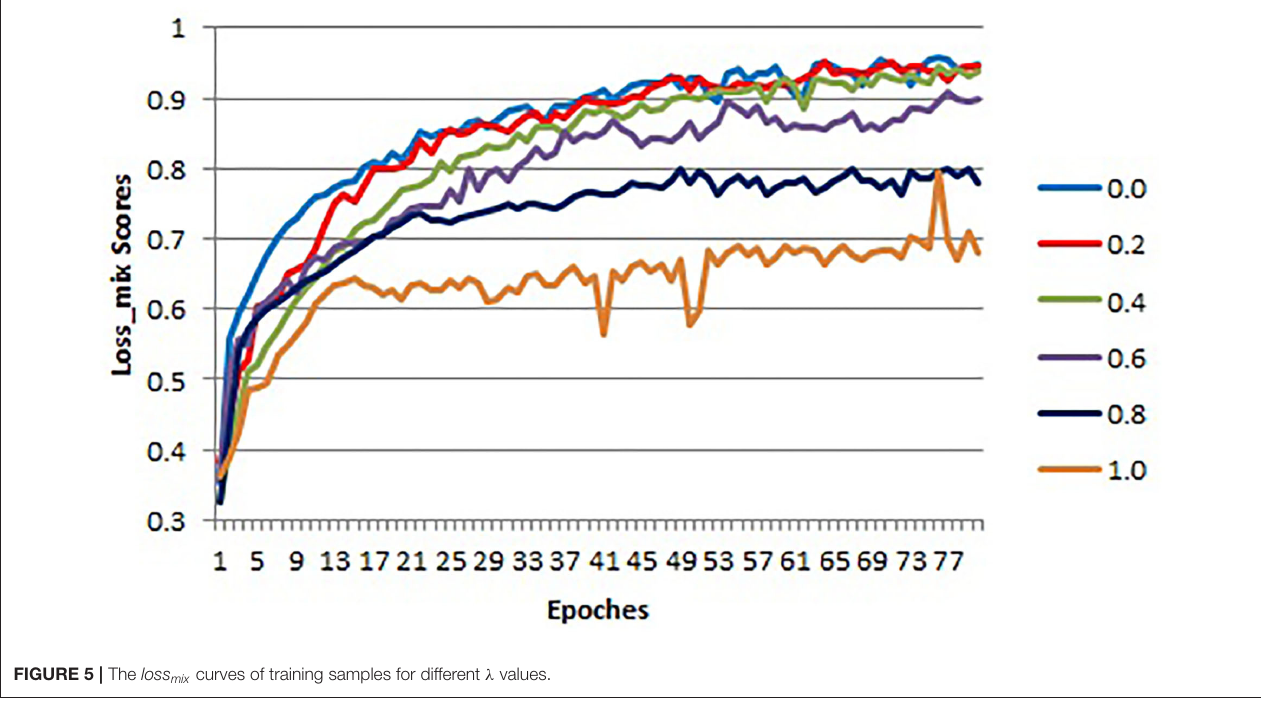
FIGURE 5 | The loss mix curves of training samples for different λ values.